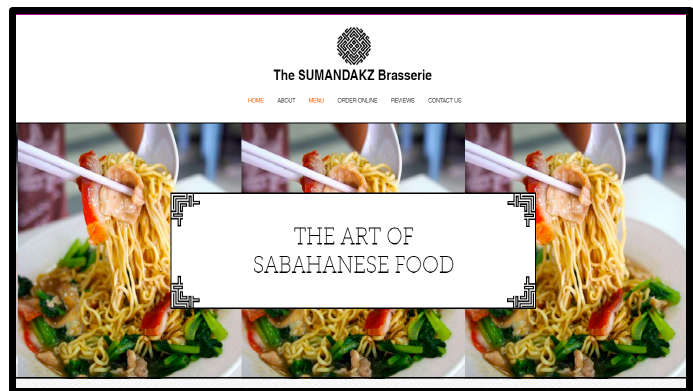
Figure 9. Homepage of the prototype web application.